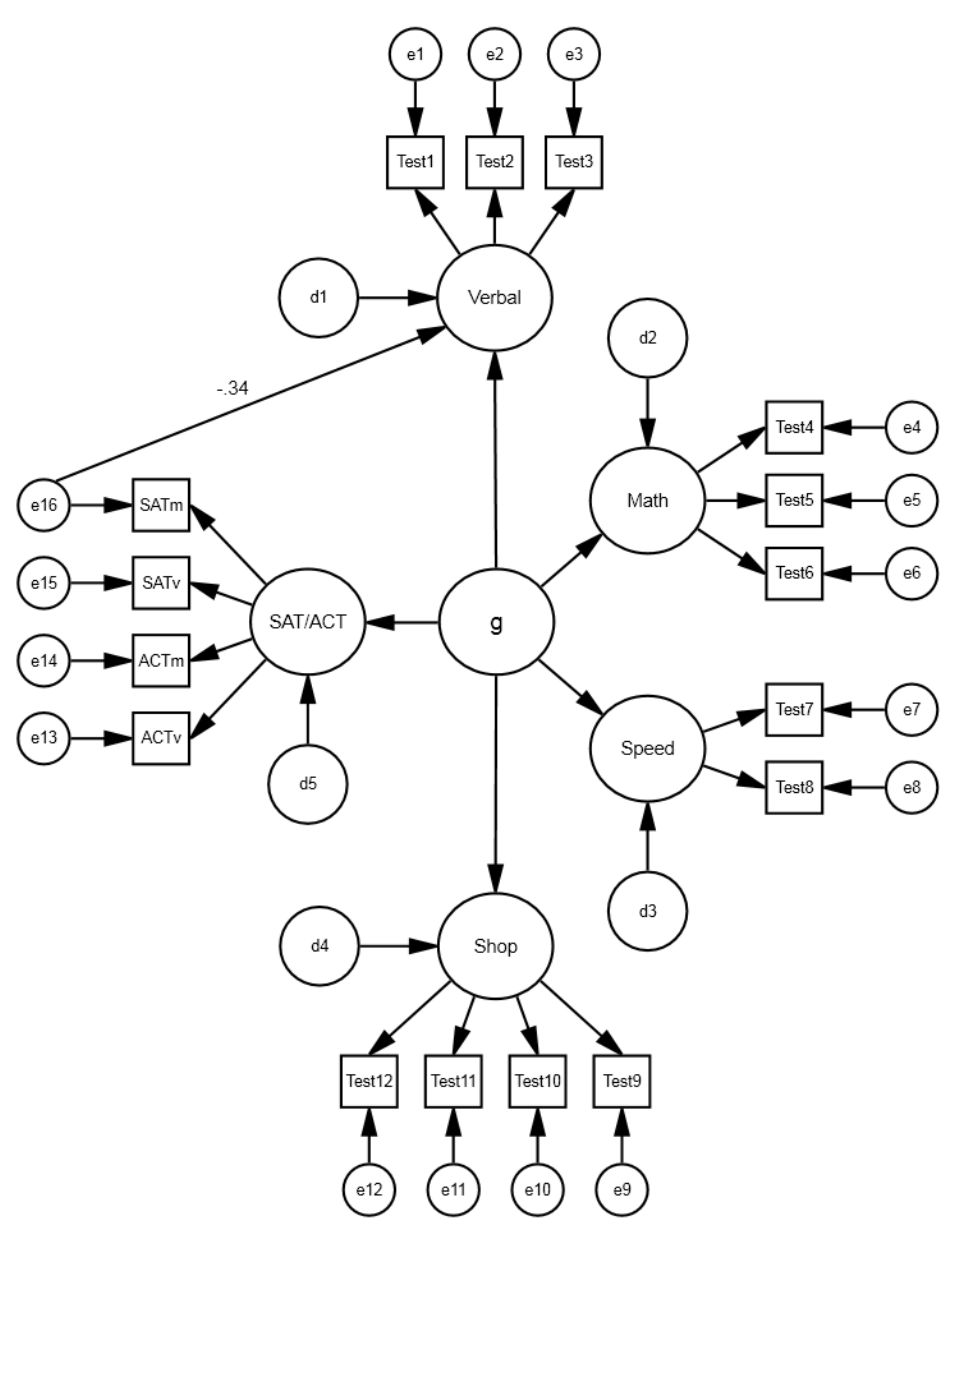
Figure 2. Relation of SAT math non- g residuals with verbal ability. g was based on the ASVAB, which also estimated four specific abilities (verbal, math, speed, and shop). The SAT/ACT factor was based on the math (SATm and ACTm) and verbal (SATv and ACTv) subtests. The SAT math residuals (e16) negatively predicted verbal ability (beta = -.34; shown in figure) and positively predicted math ability (beta = .30; not shown). In contrast, the math residuals were weakly (and not reliably) related to speed and shop abilities (betas ≈ .01) . The ACT residuals produced similar effects. Figure adapted from Coyle et al.